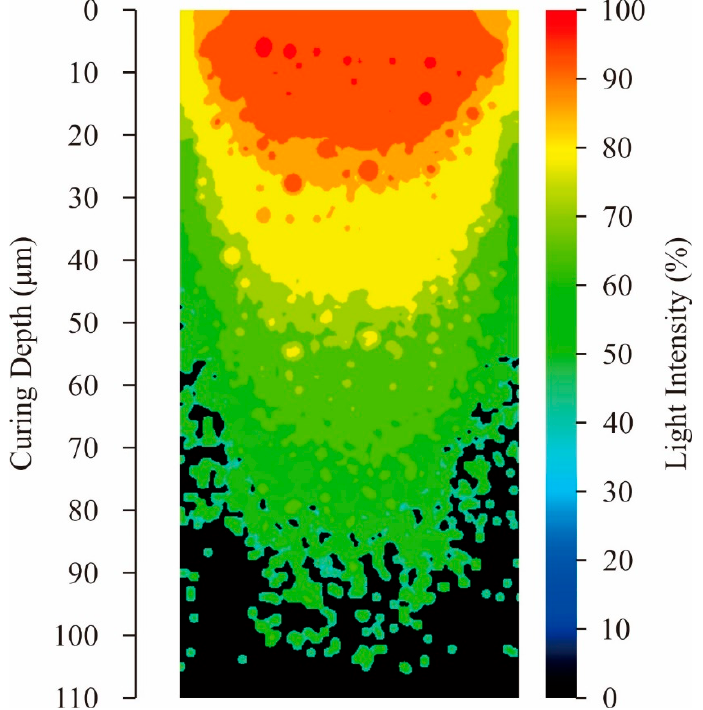
Figure 5. Intensity profile of optical irradiation at the laser spot. Vertical sections of polymerized regions were visualized. Ultraviolet (UV) light propagation in the particles gaps was simulated by the ray tracing (RT) method.